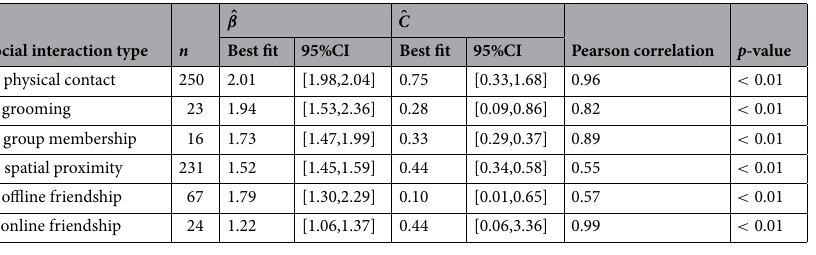
Table 2. Best fitting exponents for the 6 types of social interactions. The variable n gives for each type of social interaction the number of different networks that was included in the fit. Orthogonal regression is used to account for measurement errors in both